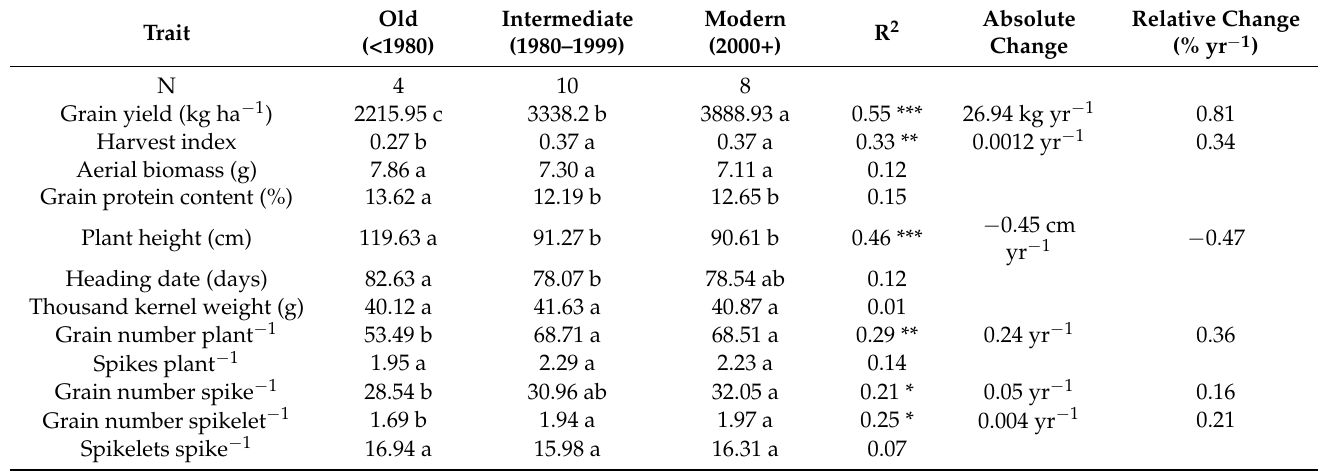
Table 3. LSMeans by periods and absolute and relative genetic changes in grain yield and agronomic traits of Argentinian durum wheat cultivars between 1934 and 2015.